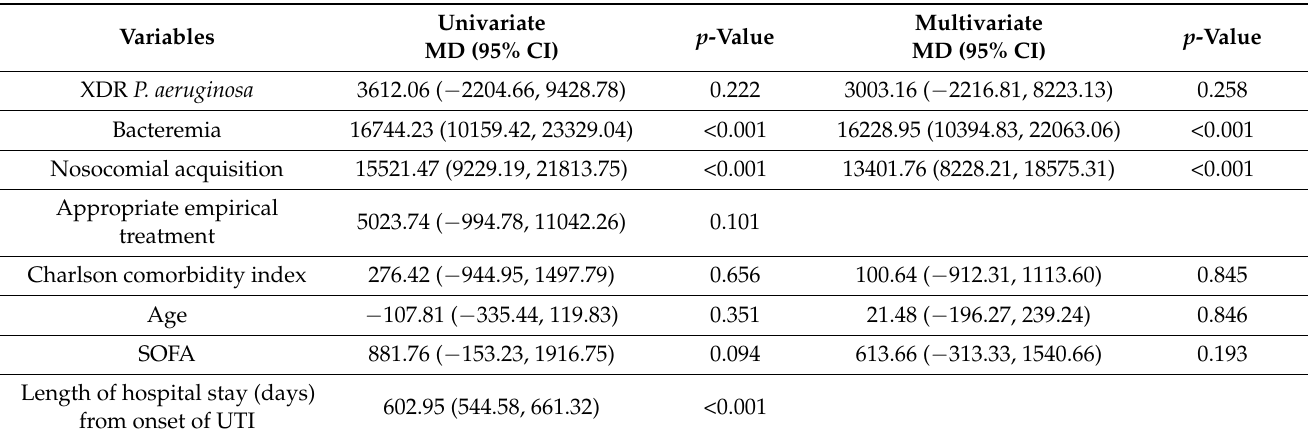
Table 6. Univariate and multivariate analysis of the economic impact (total costs in euros) per hospital admission according to different